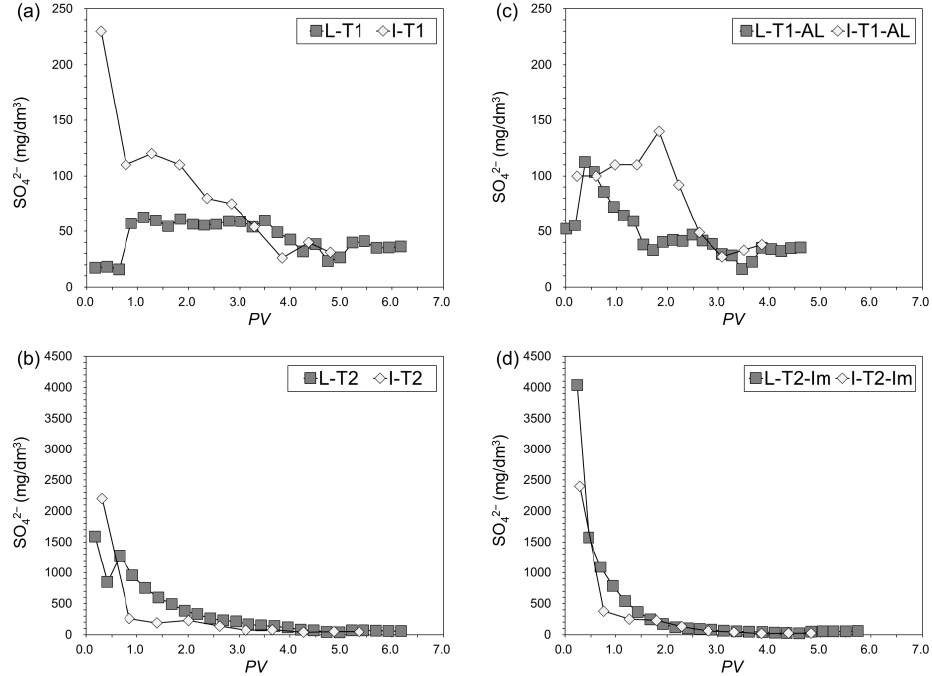
Figure 7. Changes in SO 4 2 − concentrations with PV ; ( a ) comparison between L-T1 and I-T1, ( b ) comparison between L-T2 and I-T2, ( c ) comparison between L-T1-AL and I-T1-AL and ( d ) comparison between L-T2-Im and I-T2-Im.